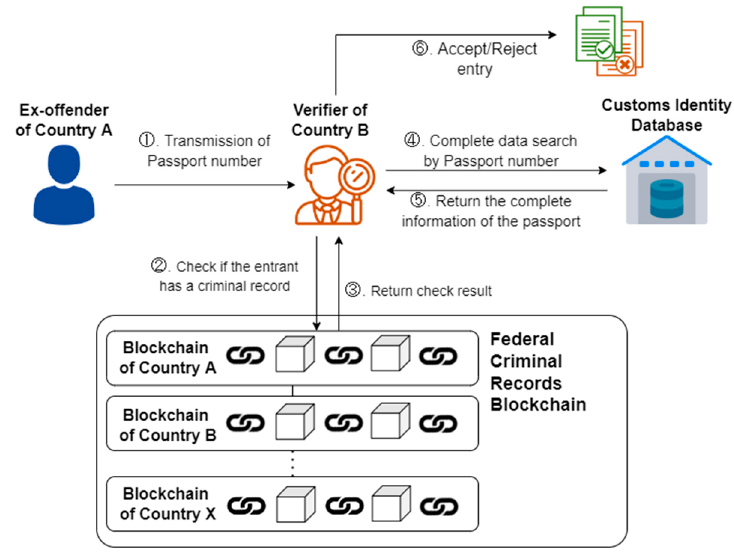
Figure 17. Transnational criminal record query scenario.